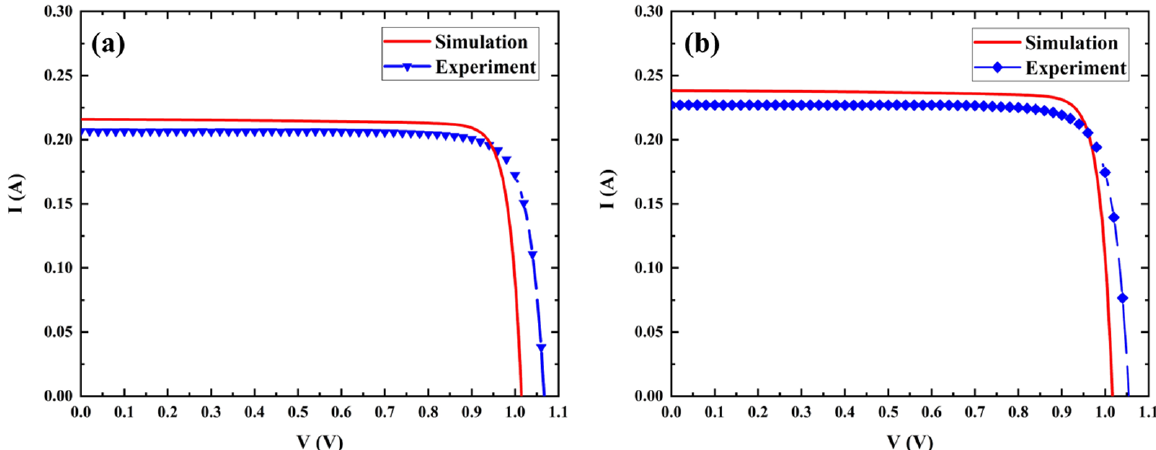
Figure 8 compared the simulated and measured I–V characteristics. Figure 8a is 500 mW irradiated on 0.5 cm 2 area, Figure 8b is 500 mW irradiated on 1 cm 2 area. Under the same incident power, the current under 50% illumination is 207 mA, which is much lower than the current under full-spot illumination, 227 mA. However, the V oc varies slightly. The model matched the output characteristics well.